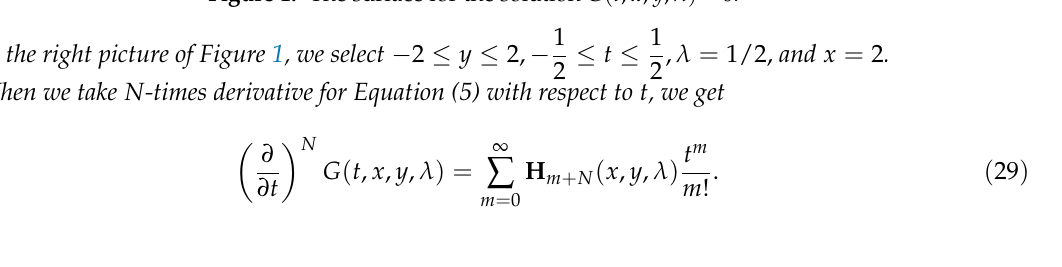
Figure 1. The surface for the solution G ( t , x , y , λ ) =